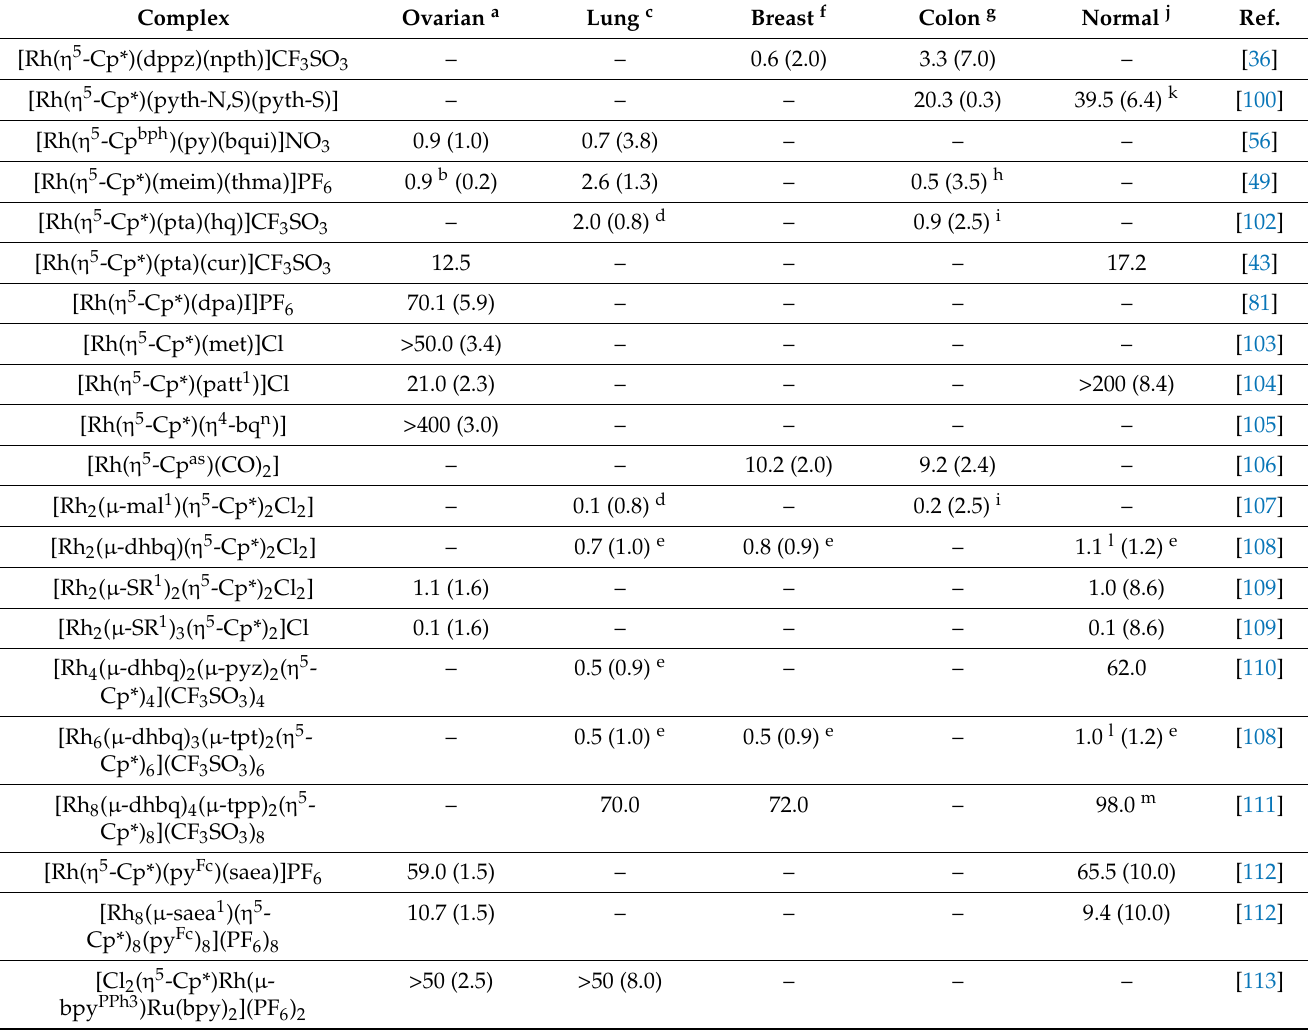
Table 2. In vitro cytotoxicity of [Rh( η 5 -Cp x )(LˆL)X] n+ complexes, different types of organorhodium arenyl complexes and multinuclear complexes (both homo- and heteronuclear) against the selected types of cancer, given together with the results obtained for the non-cancerous (normal) cells. The results are summarised together with the co-studied reference drugs (in parentheses; cisplatin unless stated otherwise), where available. Cp x = cyclopentadienyl ligand, LˆL = a bidentate ligand, X = a monodentate ligand coordinated through the P, N, O or S donor atom. Complex Ovarian a Lung c Breast f Colon g Normal j